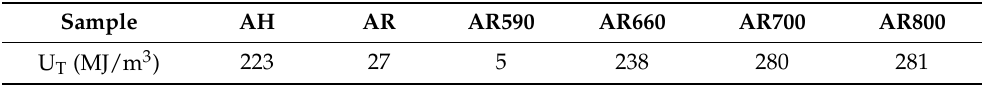
Table 6. Static toughness (U T ) of various samples for